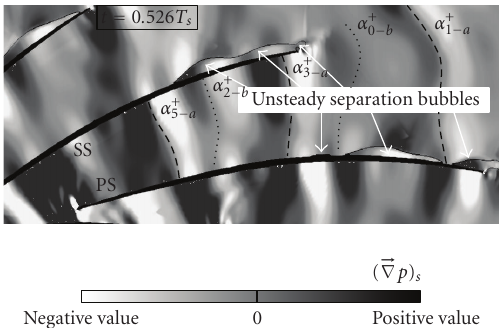
Figure 14: Pressure gradient in the flow direction at 50% height. Black contour: zero—isovalue of the azimuthal velocity V θ